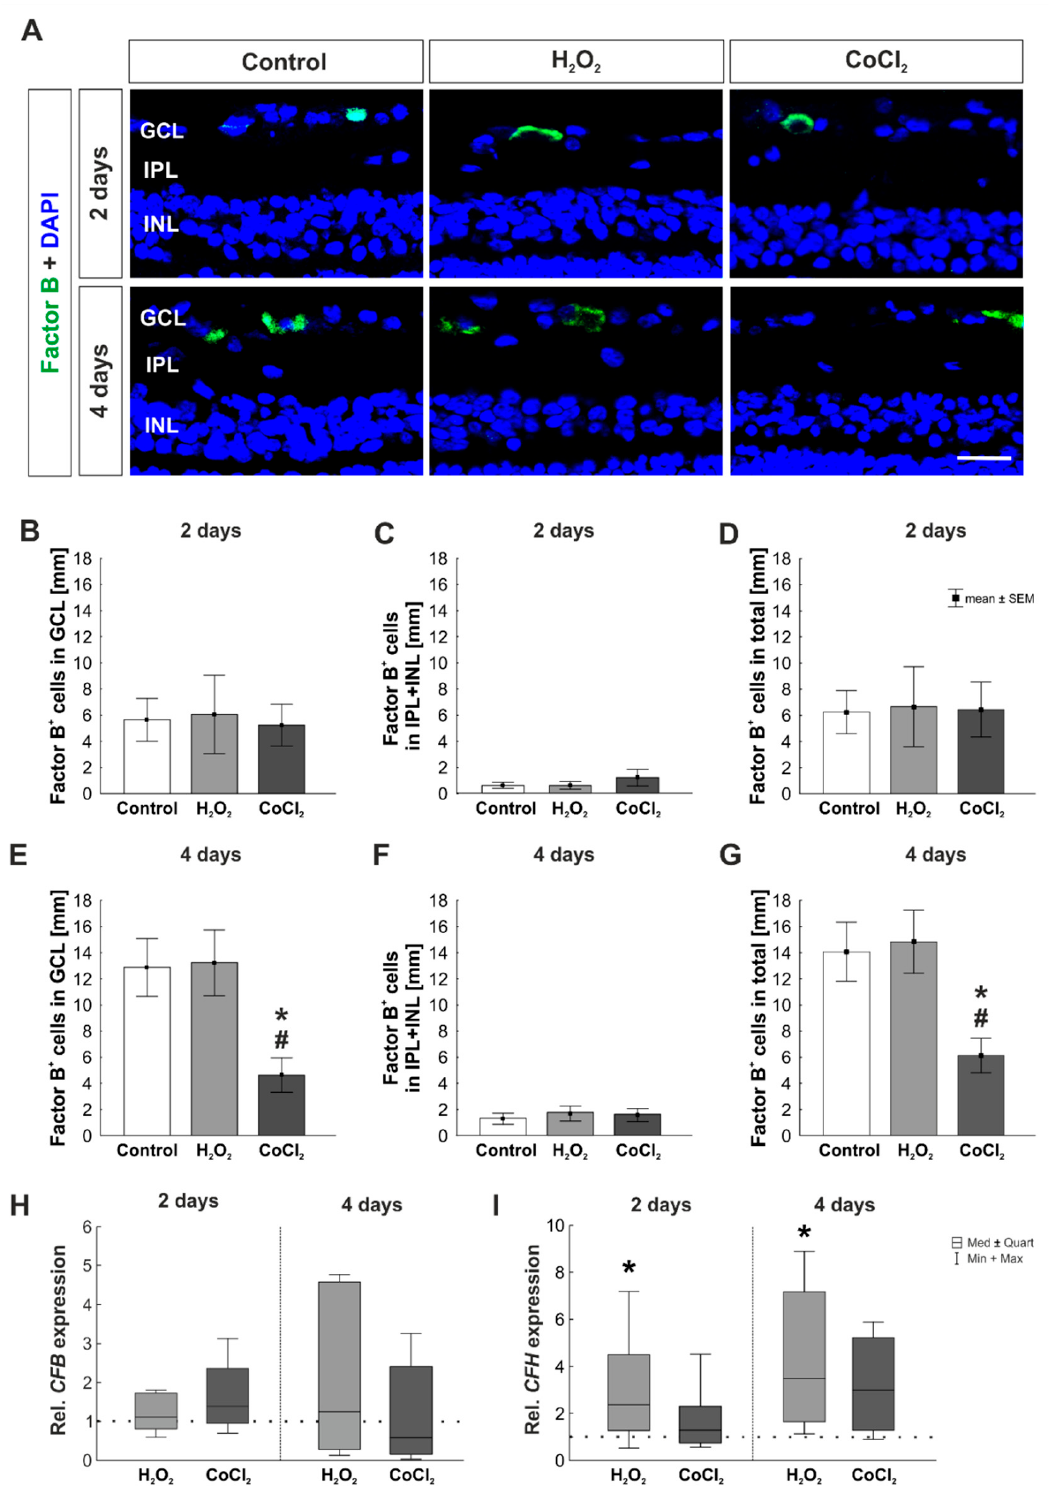
Figure 7. No activation of the complement system via the alternative pathway. ( A ) Retinal cross-sections were stained with an anti-factor B antibody (green), to investigate the alternative pathway. Cell nuclei (DAPI) are shown in blue. ( B ) At two days, neither H 2 O 2 nor CoCl 2 had any effect on the number of factor B + cells in the GCL. ( C ) Additionally, in the IPL and INL, no changes were noted in factor B + cell counts through H 2 O 2 or CoCl 2 . ( D ) In accordance, in the total retina the factor B + cells were unaltered. ( E ) Interestingly, CoCl 2 led to a significant loss of factor B + cells in the GCL at four days ( p = 0.02). ( F ) This effect was not seen in the IPL and INL. ( G ) Regarding cell counts of factor B in the total retina, a significant loss was seen in CoCl 2 -stressed retinas at four days ( p = 0.03). ( H ) mRNA expression levels of CFB were not altered at any point in time. ( I ) However, CFH mRNA levels were significantly upregulated in H 2 O 2 -stressed retinas at both investigated points in time ( p = 0.04 and p = 0.01). GCL = ganglion cell layer; IPL = inner plexiform layer; INL = inner nuclear layer. ( B – G ): n = 8; ( H , I ): n = 4–5. Scale bar: 20 µm. Values are shown as mean ± SEM for immunofluorescence median ± quartile